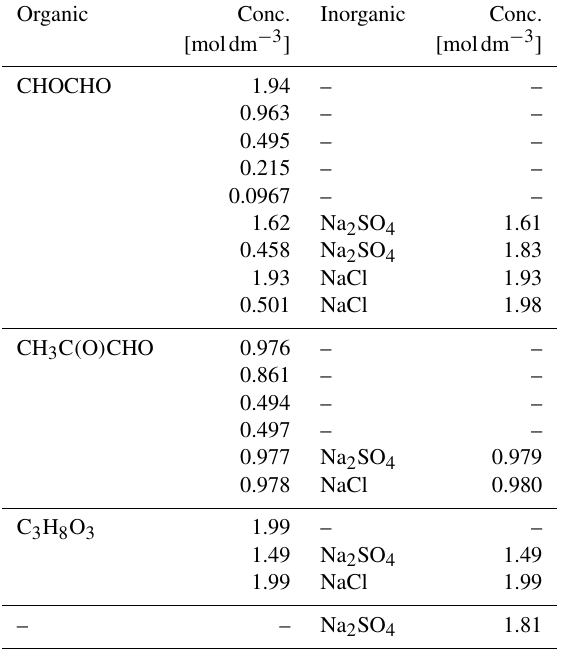
Table 2. Sample compositions, with aqueous concentrations of each solute. Organic Conc. Inorganic Conc. [moldm − 3 ] [moldm − 3 ] CHOCHO